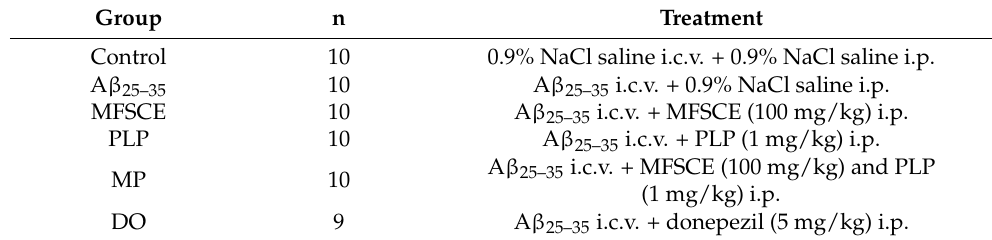
Table 1. Mice groups and treatment protocol.